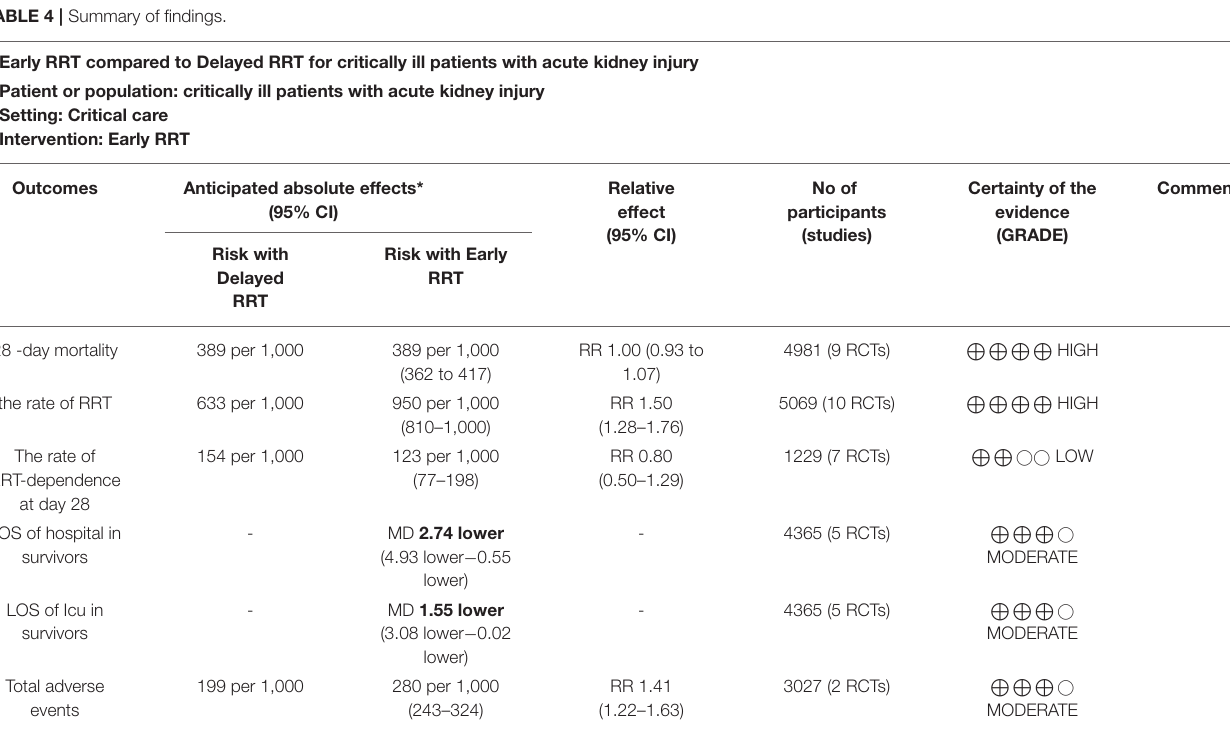
TABLE 4 | Summary of